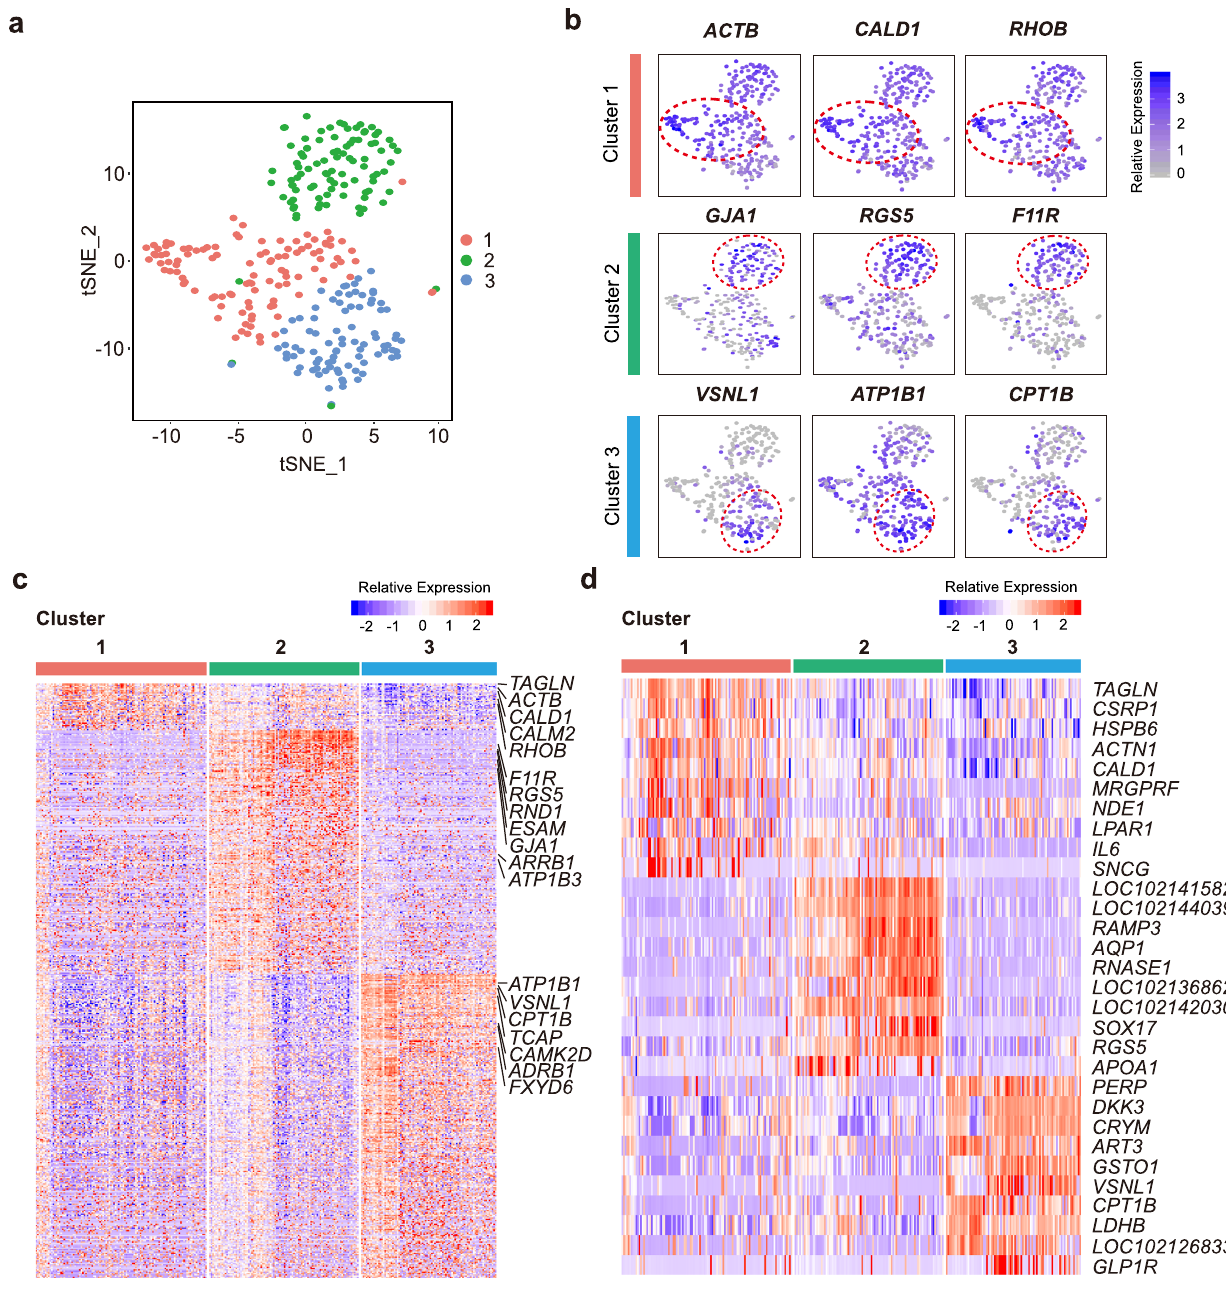
Fig. 7 Clustering analysis of cynomolgus monkey sinoatrial node (SAN) cells. a Three clusters of monkey SAN cells were identi fi ed by t -distributed stochastic neighbor embedding (t-SNE) ( n = 296 biologically independent cells of 12 independent animals). b Feature plot of speci fi c differentially expressed genes (DEGs) in each cluster and Cluster 3 was identi fi ed as the core cell cluster. VSNL1 was also speci fi cally expressed in Cluster 3. Location of different clusters was marked with the red circle. c Heat map shows all DEGs of each cluster. The main DEGs of each cluster were indicated in the right column. d Heat map shows top10 speci fi c DEGs of each